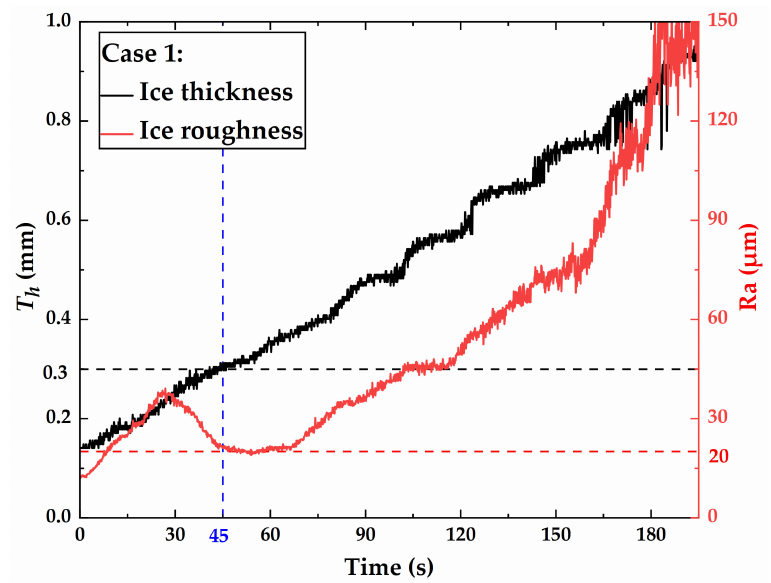
Figure 16. The experimental results of case 1, where the black solid line is the growth process of ice thickness, and the red solid line is the variation in ice surface